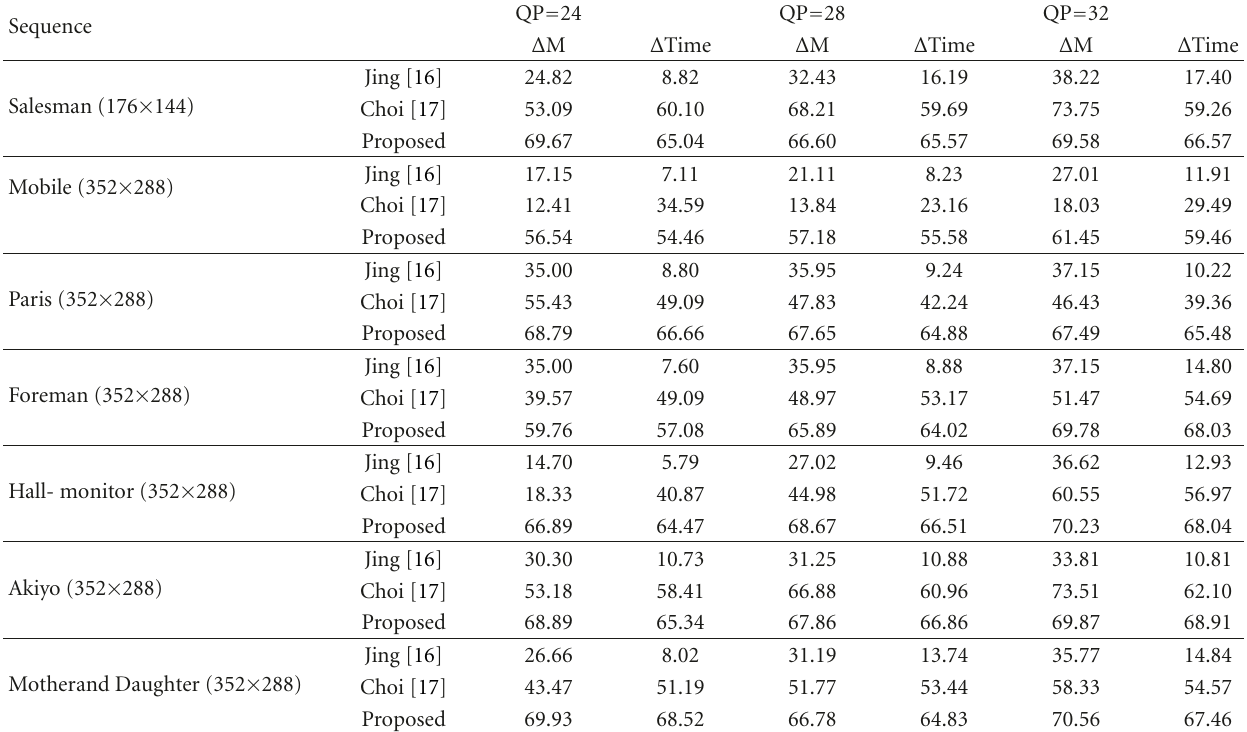
Table 2: Experimental results of mode saving factor and encoding time